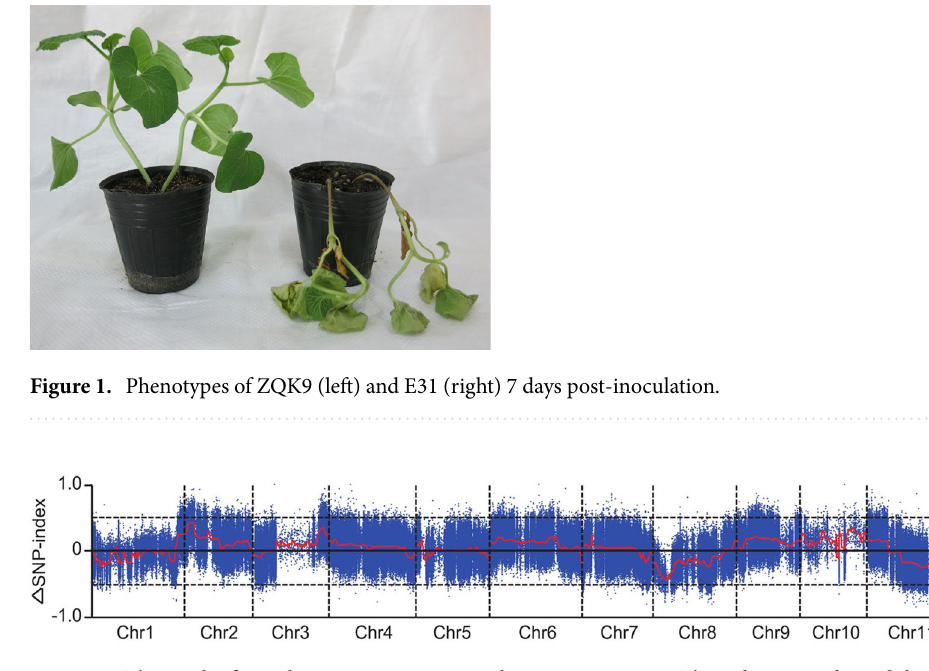
Figure 2. The result of gene location association analysis using BSA-seq. The red arrow indicated the initial mapping